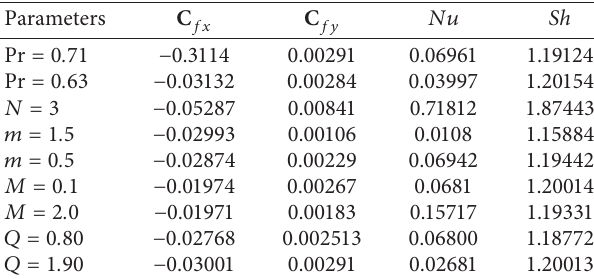
Table 1: Values of the Nusselt number, Sherwood number, and skin friction.